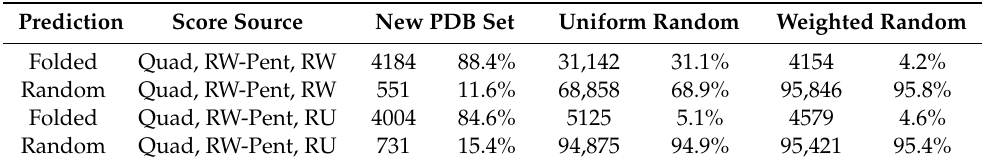
Table 2. Comparison of the foldability predictions using combinations of quadruplet and pentuplet scores.